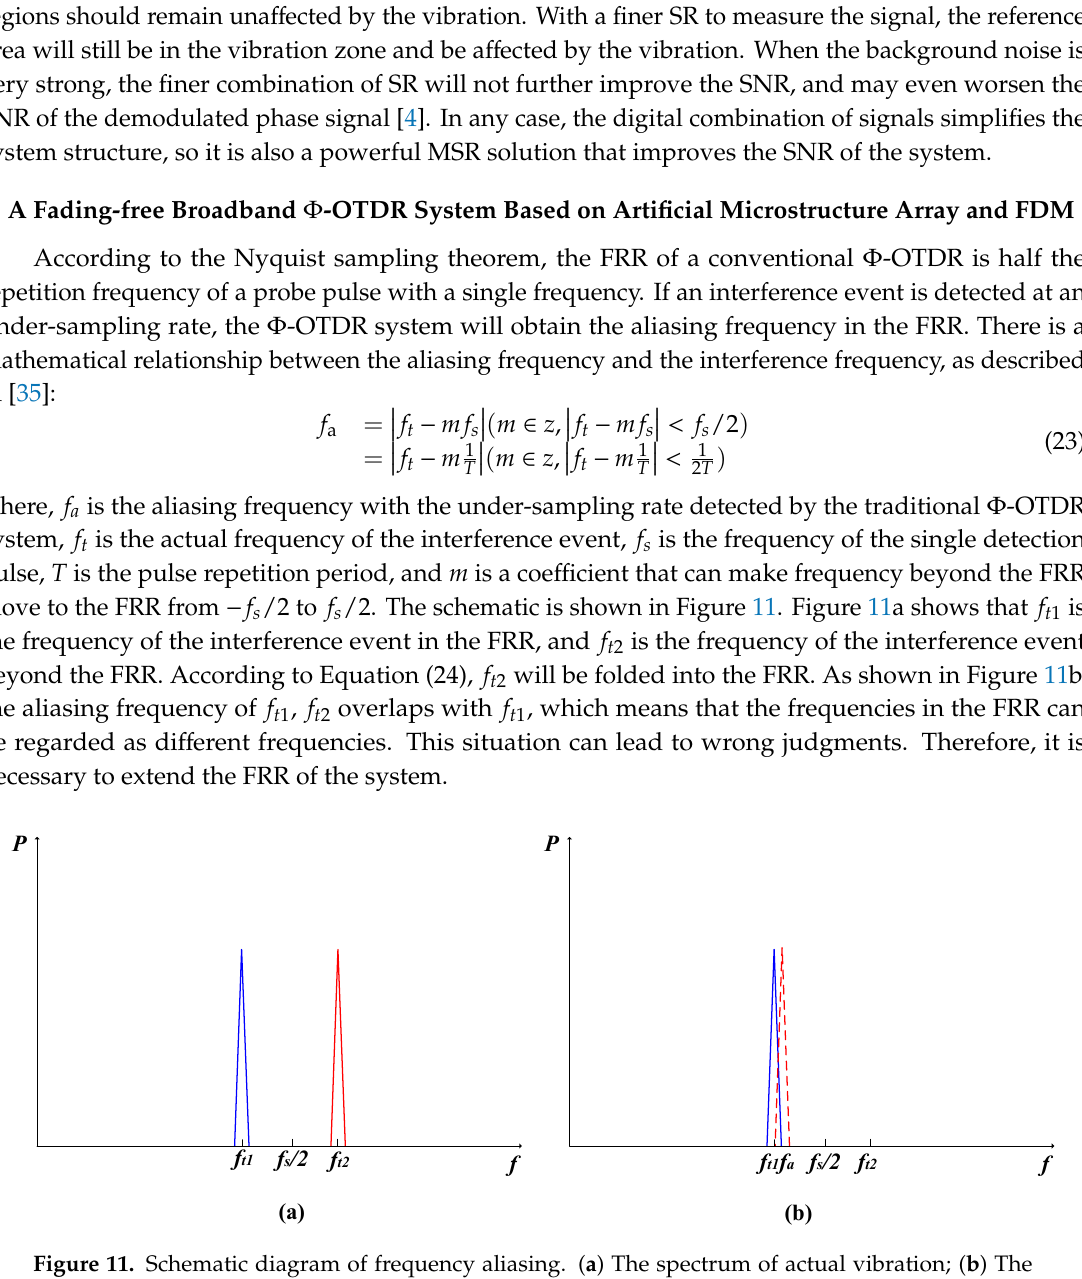
Figure 11. Schematic diagram of frequency aliasing. ( a ) The spectrum of actual vibration; ( b ) The spectrum of detection vibration.